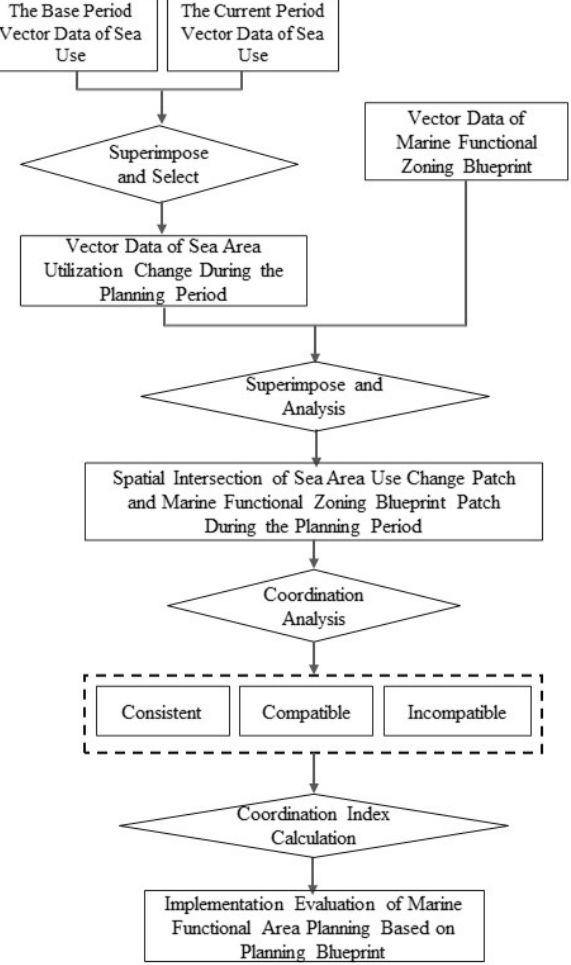
Figure 1. Implementation evaluation of marine functional zoning based on planning blueprints.